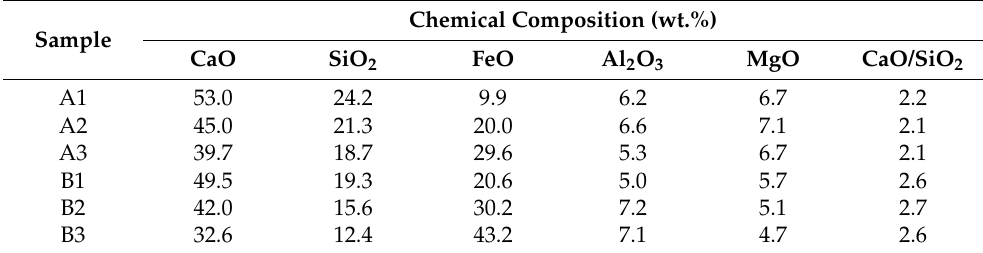
Table 1. The composition of the slag